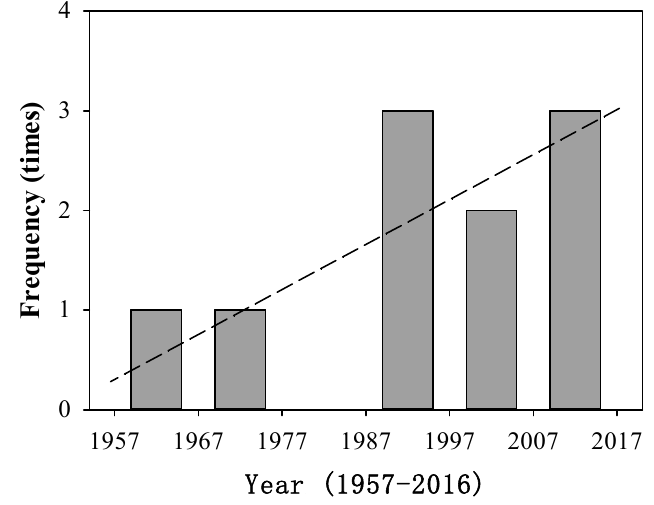
Figure 11. Long-term trends in the frequency of heavy rainfall from 1957 to 2016 in Lake Liangzi.